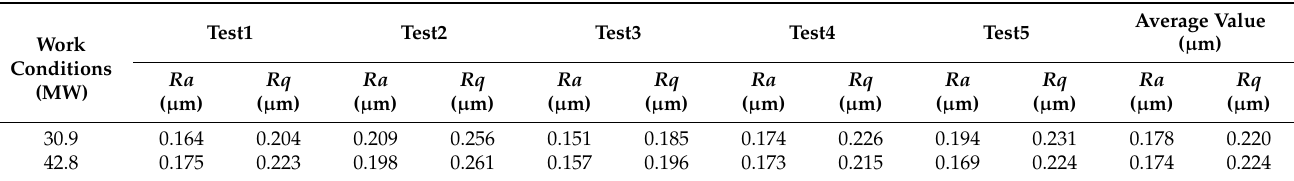
Table 2. Roughness measurement (after